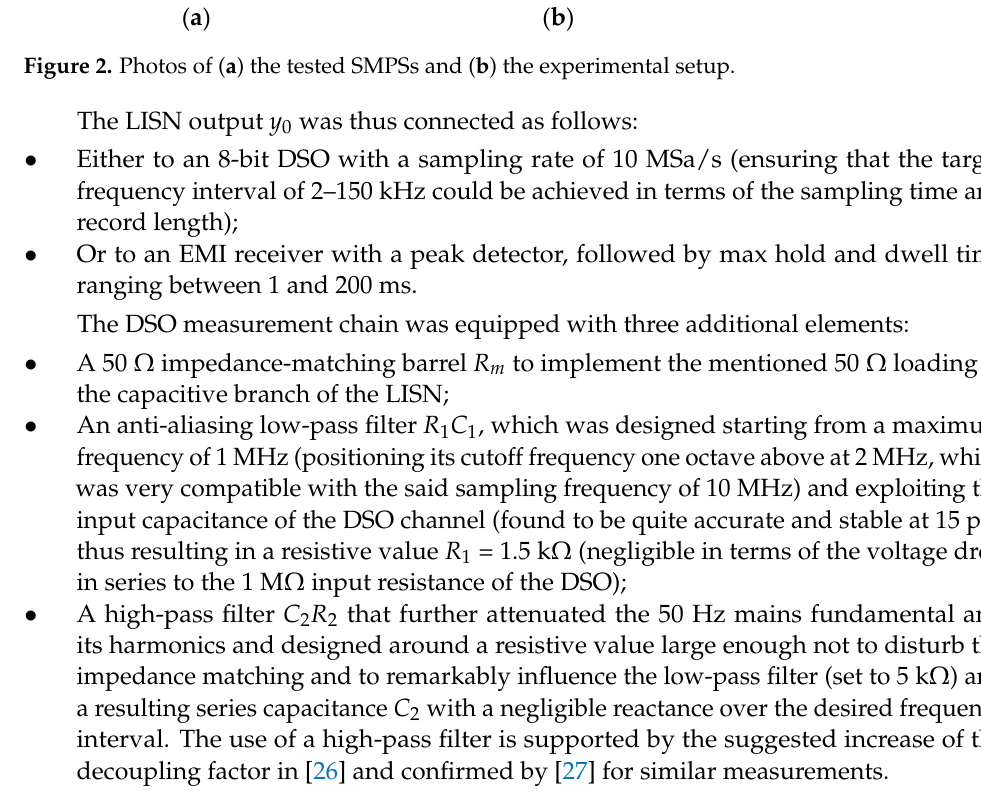
Figure 2. Photos of ( a ) the tested SMPSs and ( b ) the experimental setup.